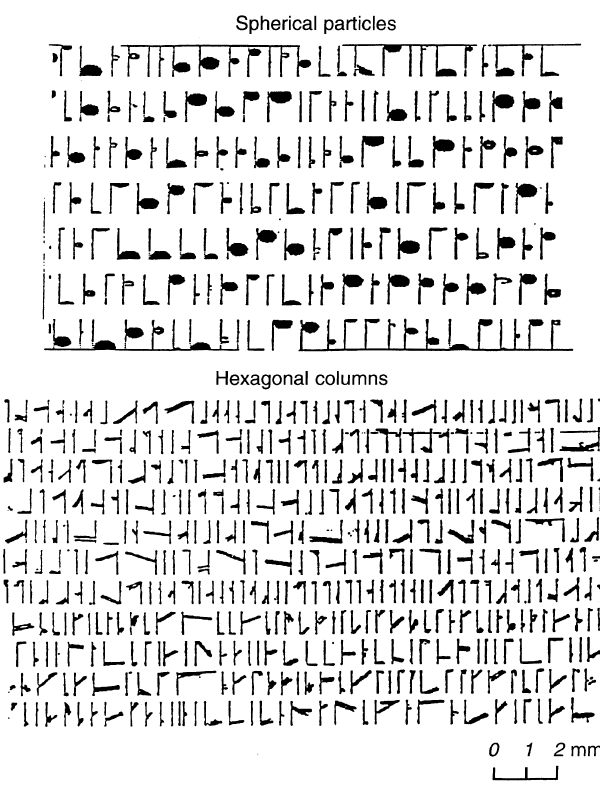
Table 2. Values of (cid:97) for di(cid:128)erent pixel configurations determined from aircraft measurements Number of